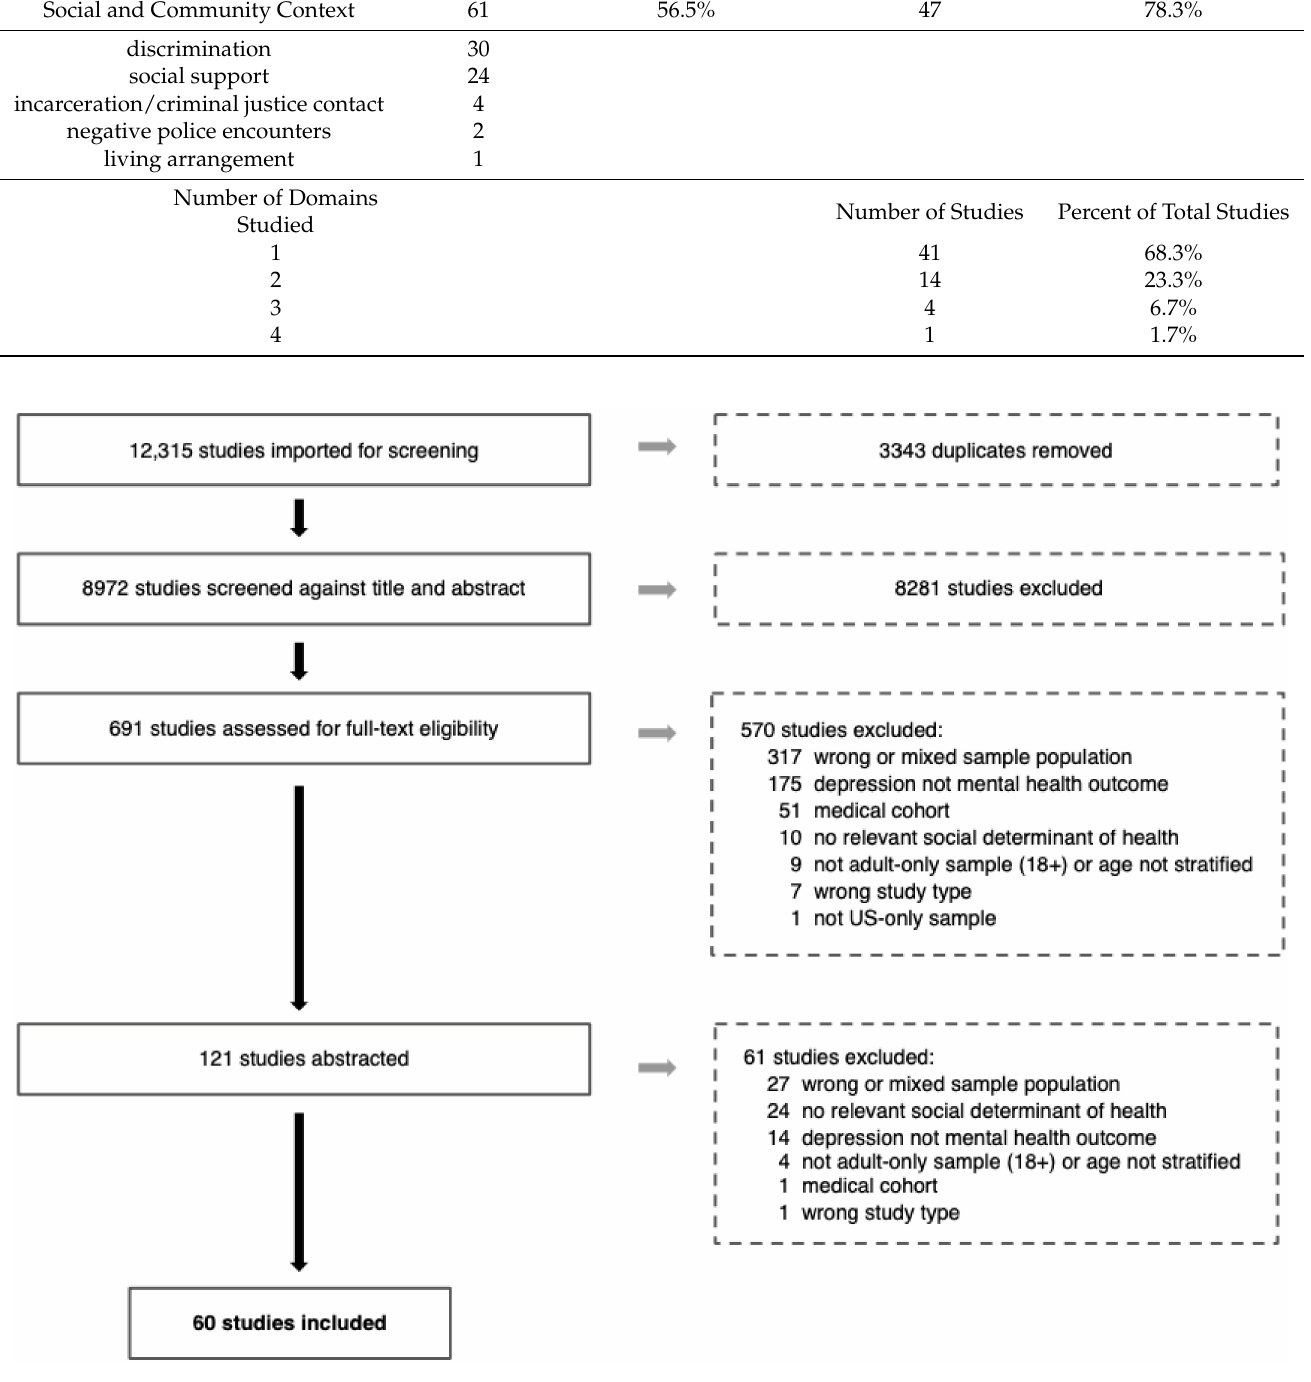
Figure 1. Search and Selection